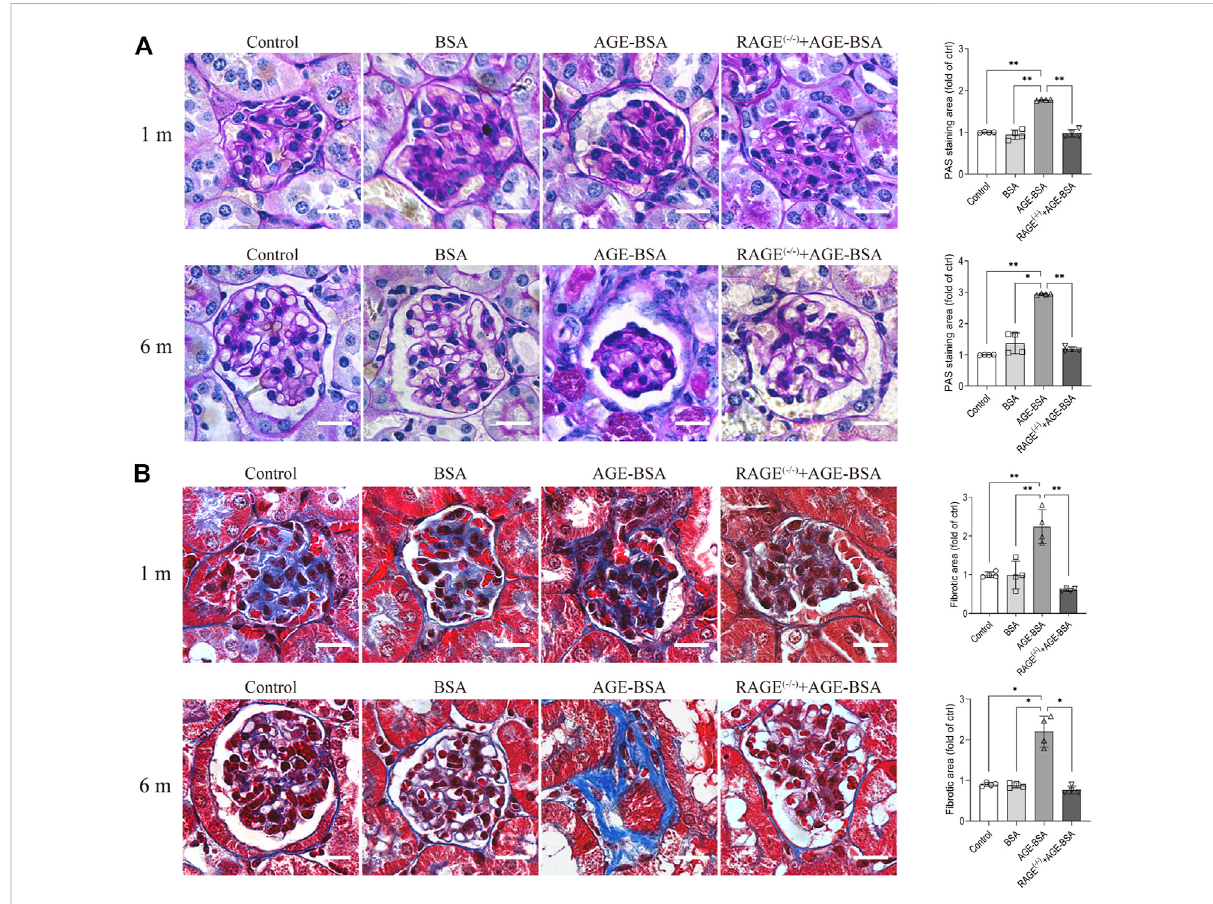
FIGURE 4 AGE-BSA induces RAGE-mediated renal fi brosis. (A) PAS staining and (B) Masson ’ s staining were conducted in renal tissues from WT and RAGE ( − / − ) mice after 1 and 6 m AGE treatment. Scale bar = 20 μ m. n = 4, * p < 0.05, and ** p < 0.01.